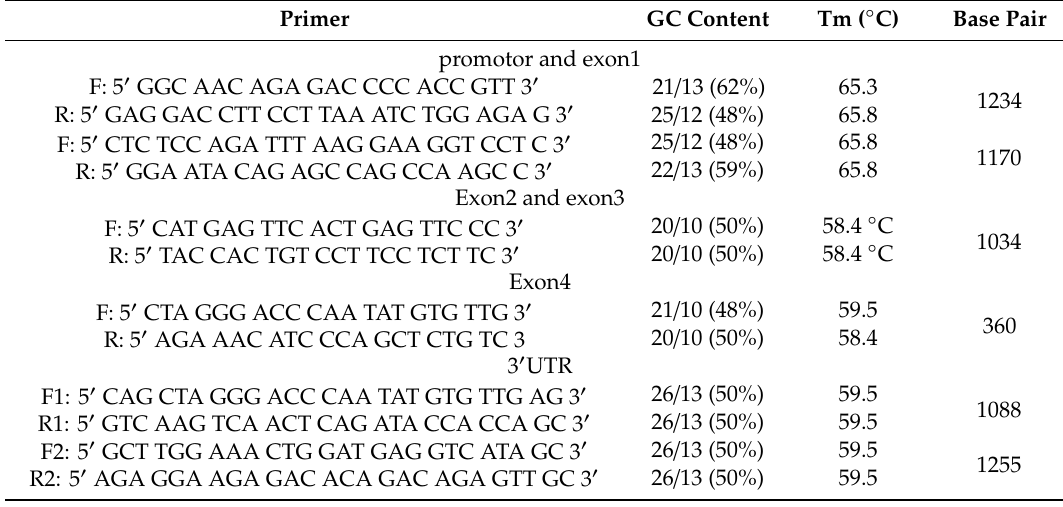
Table 1. Primers used for CTLA4 in this study.